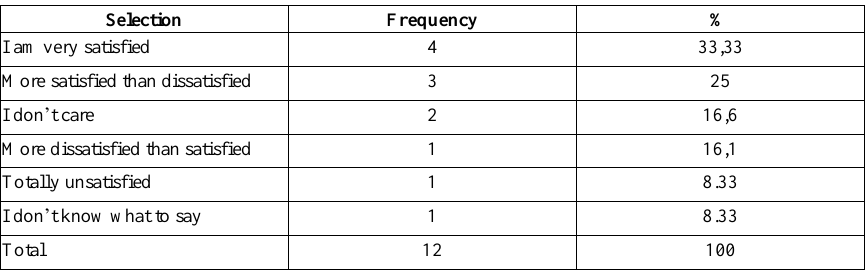
Table 2. Levels of student satisfaction for the subject Usability in software development Selection Frequency